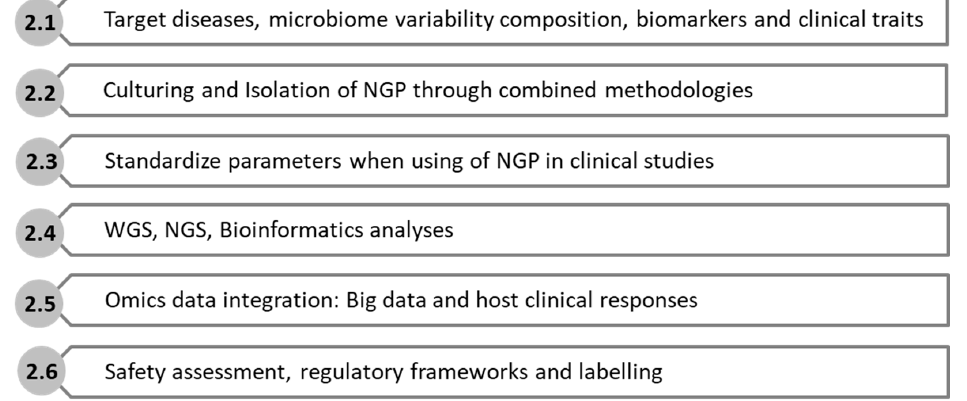
Figure 1. Next Generation Probiotics (NGP) criteria to be applied for searching strategies, Whole Genome Sequencign (WGS), Next Generation Sequencing (NGS):